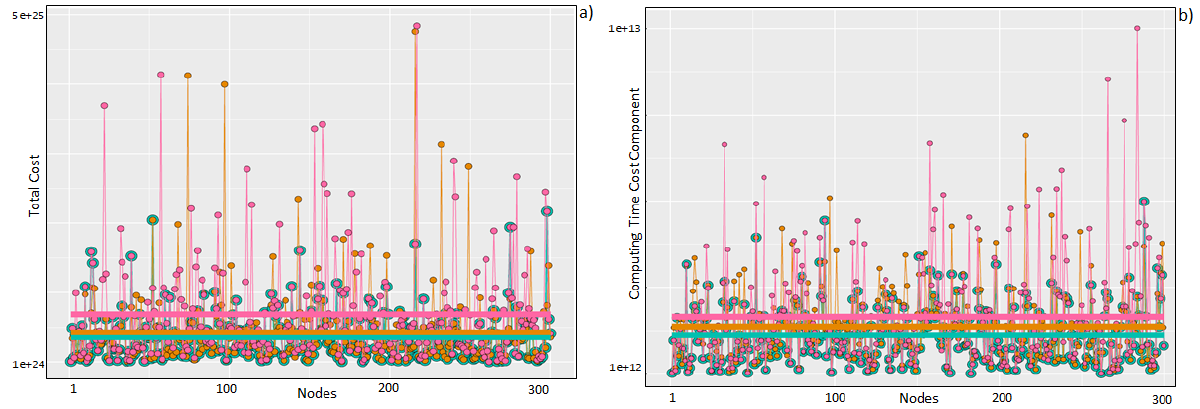
Figure 6. Cost H it versus nodes: ( a ) total cost; ( b ) computing time component. Punctual and mean values are shown for three cases: local computation (in pink), offloading to neighbors (in orange), and cognitive computing decision (in